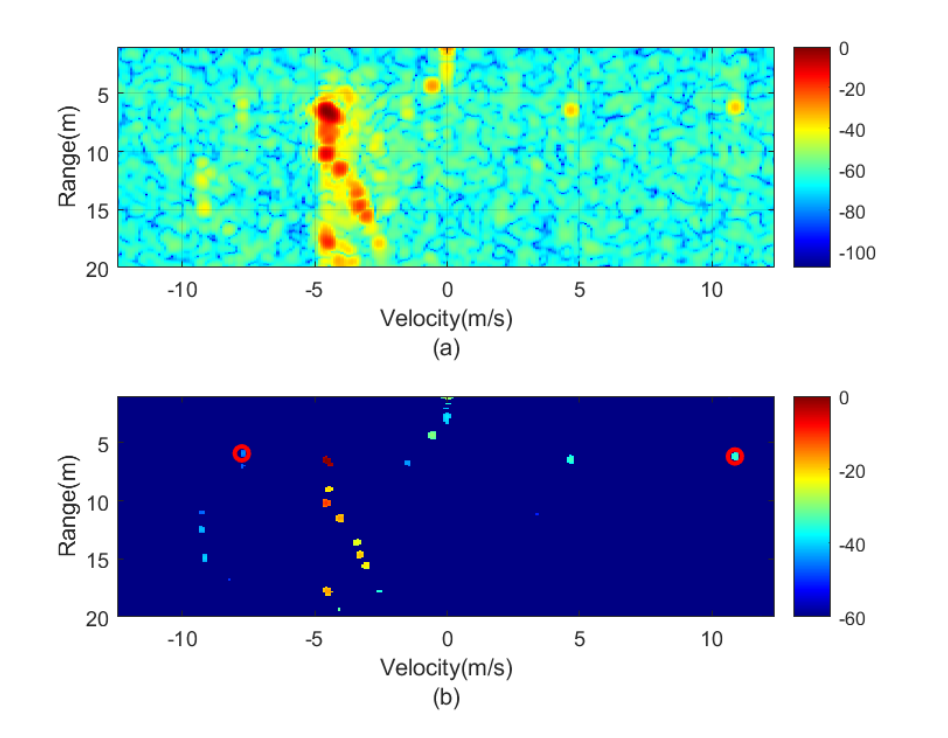
Figure 15. Measured range—Doppler map ( a ) and detection after CFAR processor ( b ) for the transponder modulated at 1500